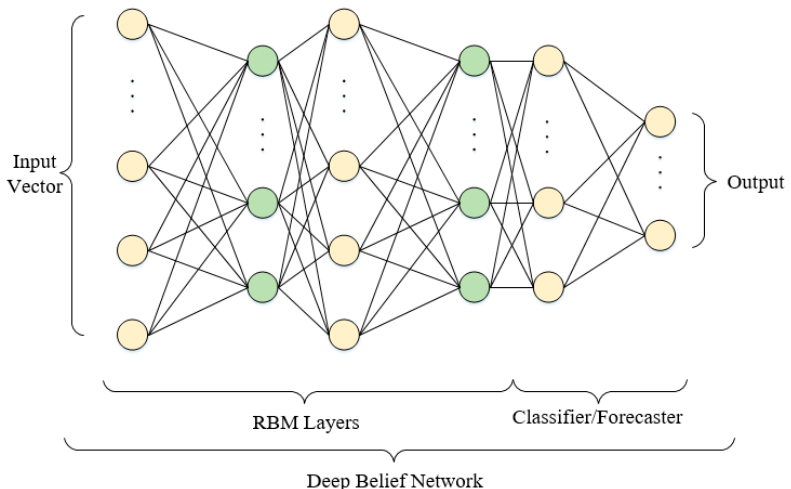
Figure 5. Example of a structure for a deep belief network .